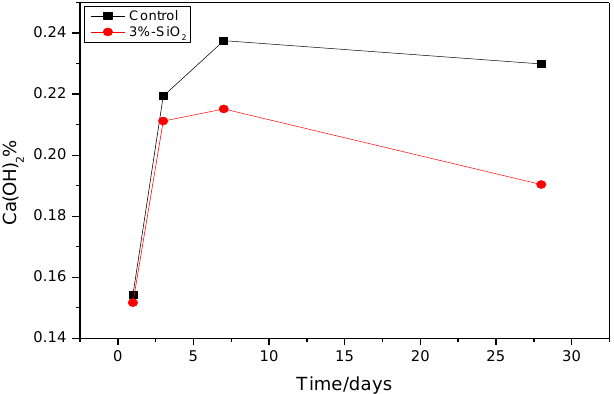
Figure 10. The mass loss of Ca(OH) 2 at difference ages.